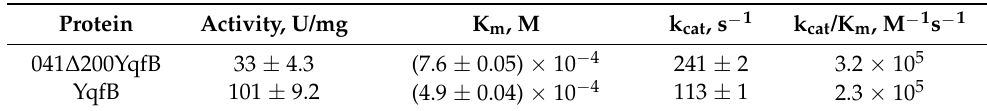
Table 4. Comparison of catalytic parameters of free YqfB and tube-fused YqfB on N 4 -acetyl-2 (cid:48) -